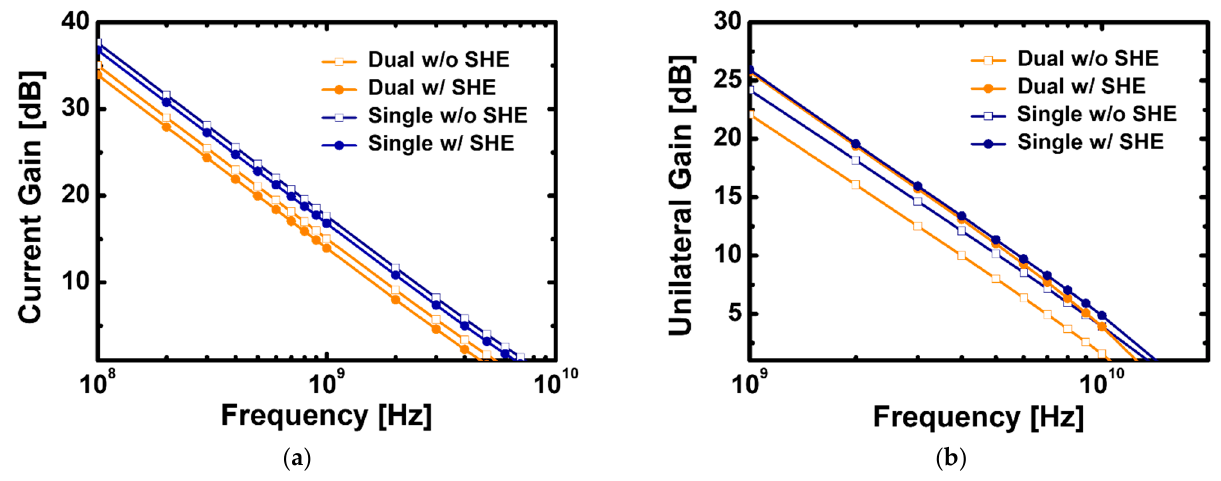
Figure 12. ( a ) Cut-off frequency and ( b ) maximum frequency of recessed-gate GaN MOSFET using the stacked TiO 2 /Si 3 N 4 dual-layer insulator and Si 3 N 4 single-layer insulator with and without self-heating effect on SiC substrate.